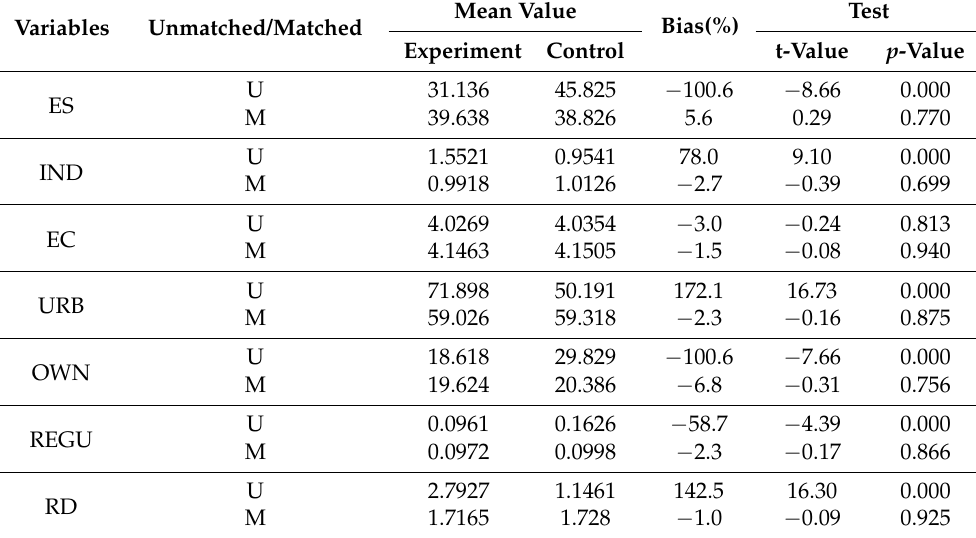
Table 3. Stationary test of variables before and after